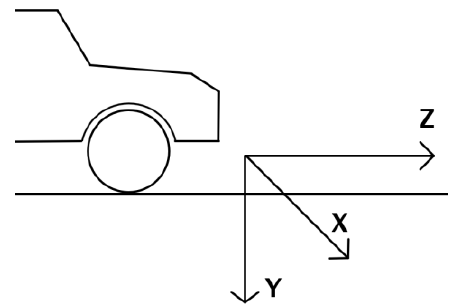
Figure 11. The coordinate system of the vehicle.